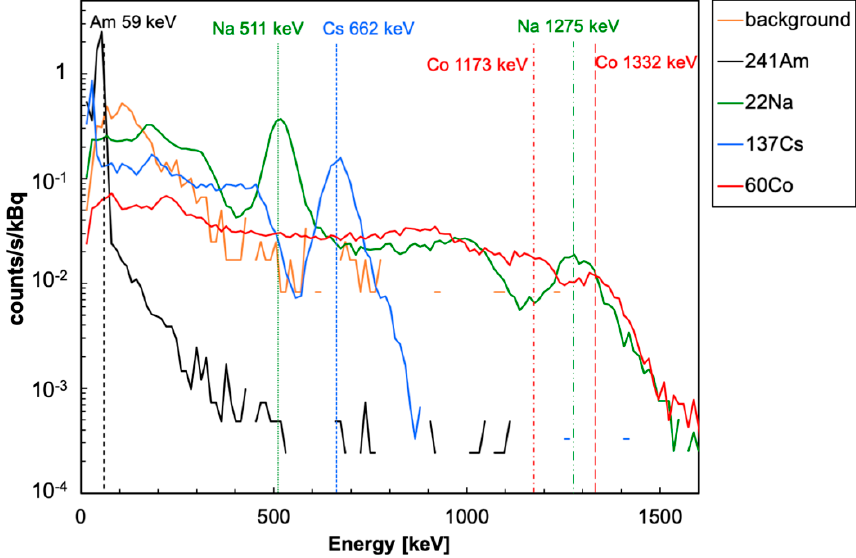
Figure 7. The energy spectra from Figure 6 normalized to the respective source activity.